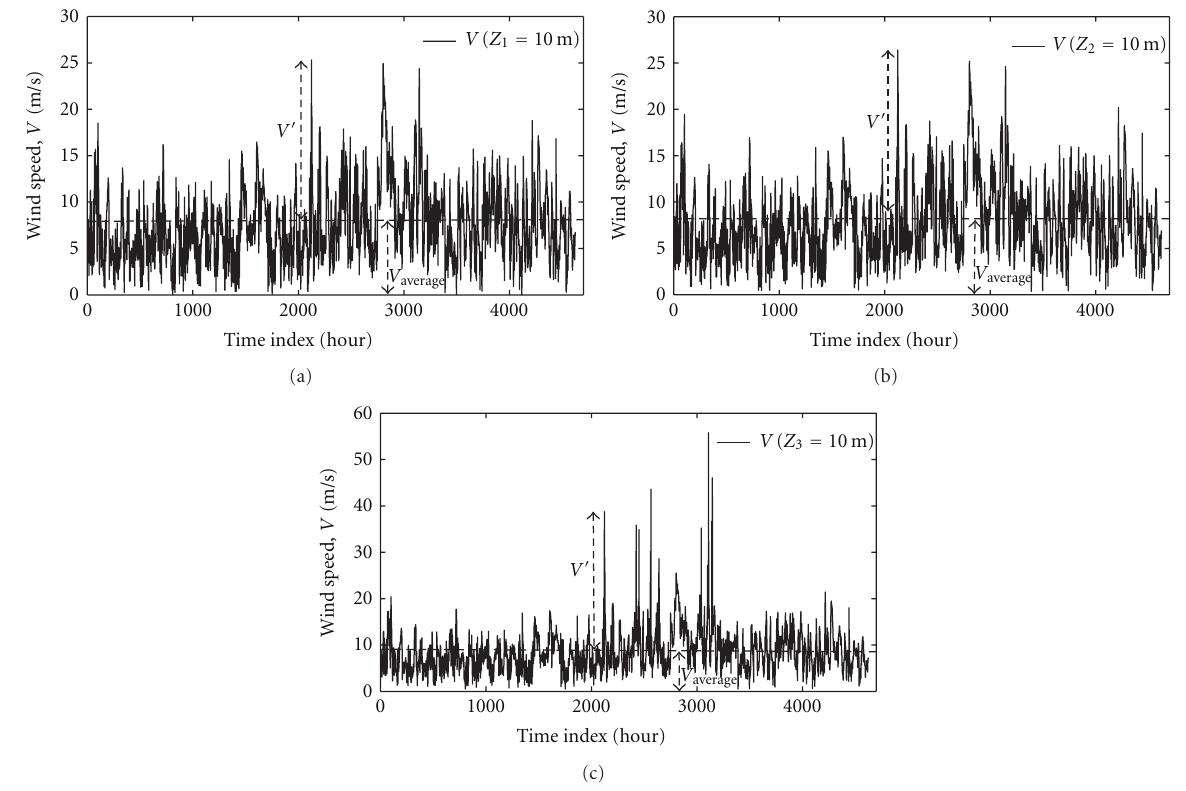
Figure 1: Karaburun wind speed records at di ff erent